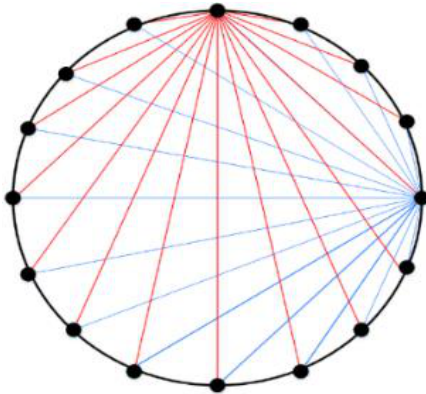
Figure 3. The scanning mode of ring array.